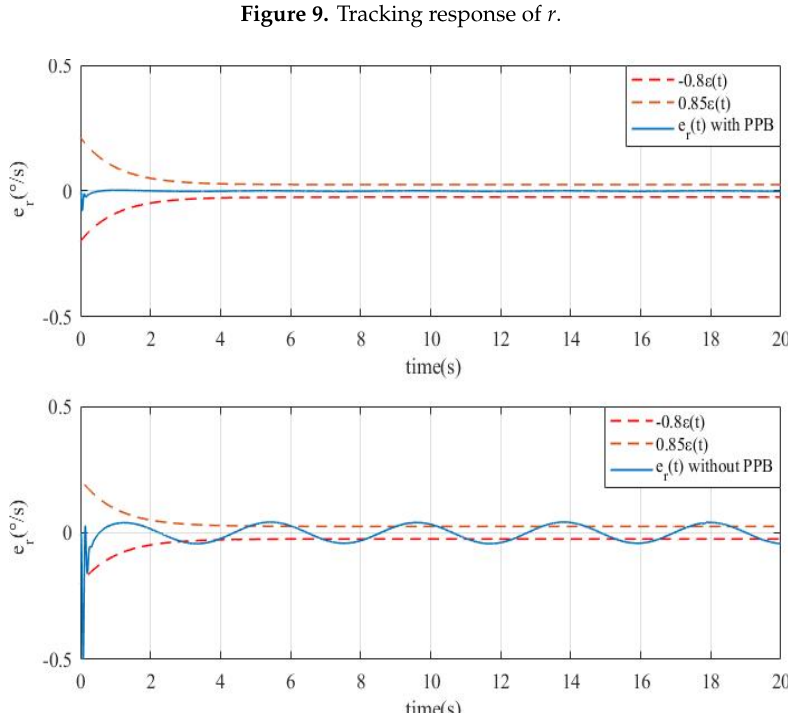
Figure 10. Tracking error of r .